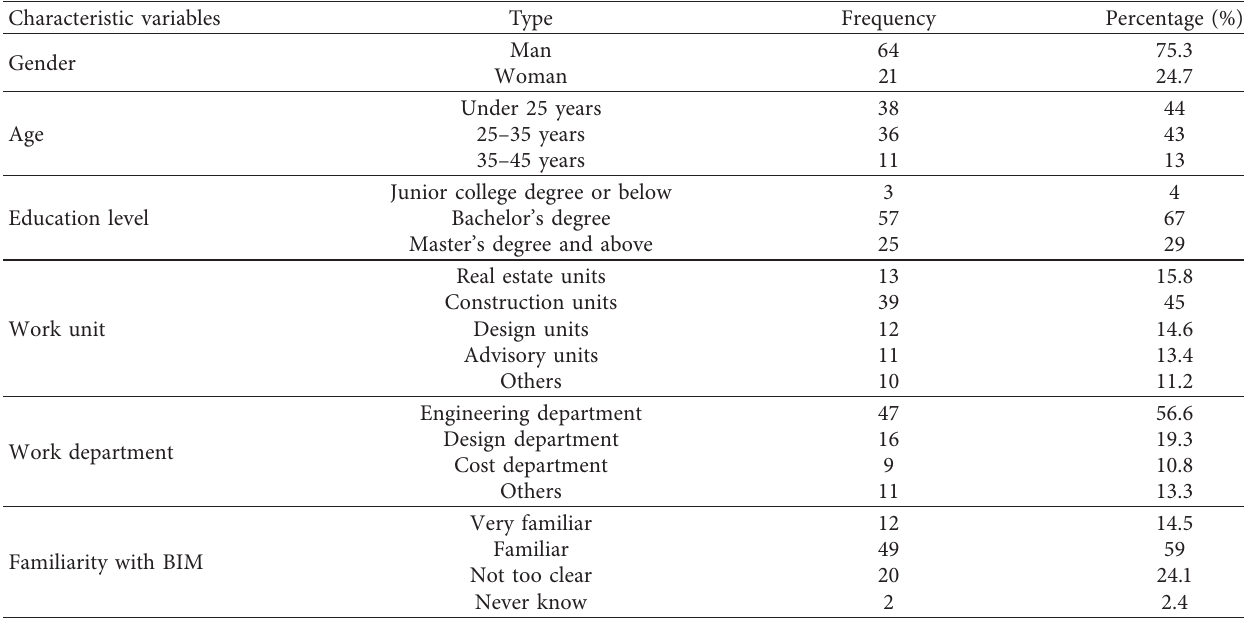
Table 2: Basic information statistical analysis.